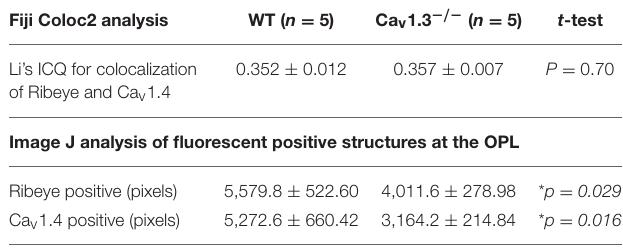
TABLE 3 | Analyses of synaptic structures at the OPL. Fiji Coloc2 analysis